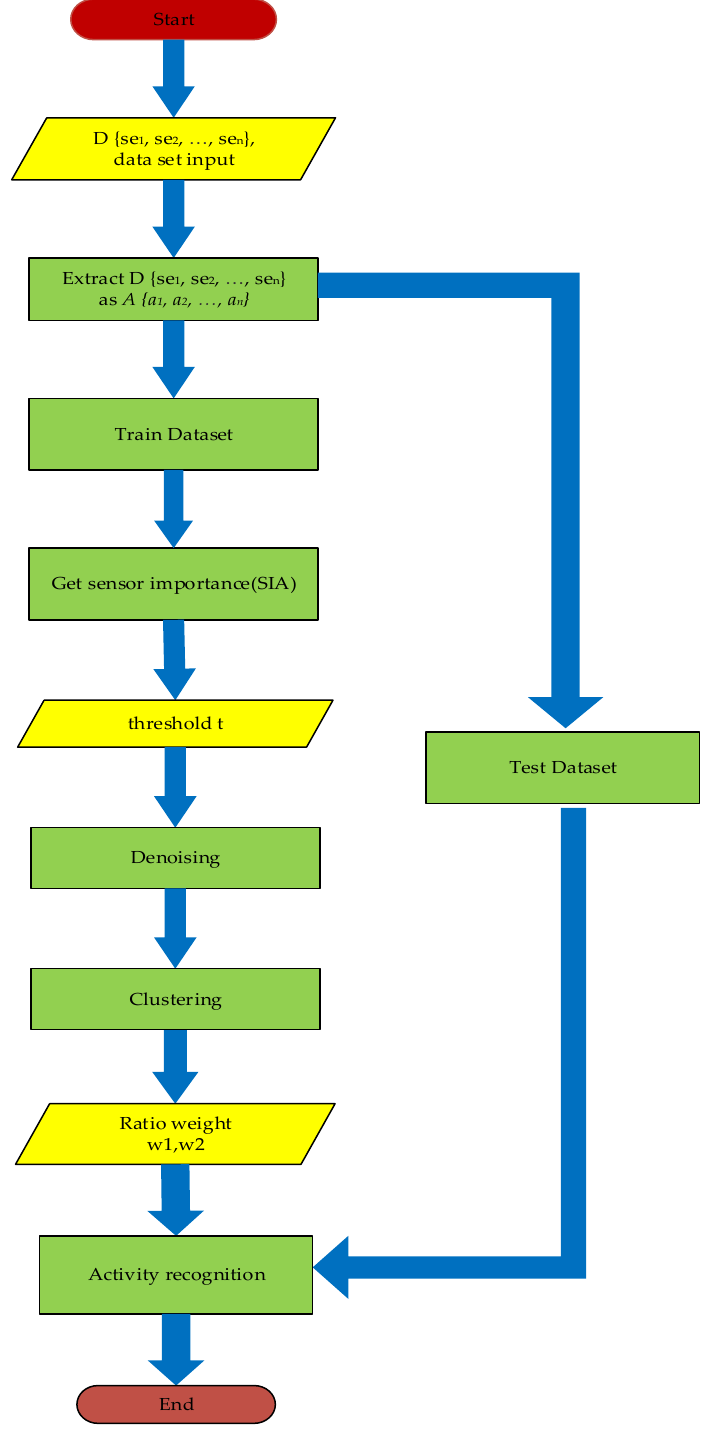
Figure 1. Process for the activity recognition.